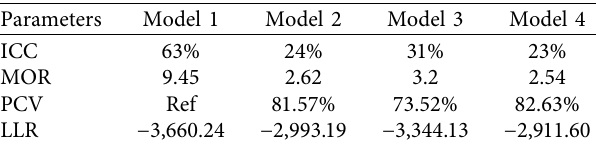
Table 4: Random effect and model comparison for factors asso- ciated with institutional delivery, Ethiopia,